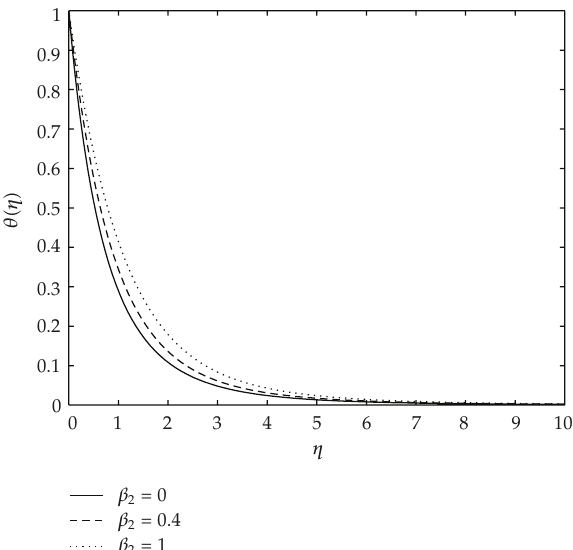
Figure 10: Temperature profiles for various values of β 2 with M (cid:5) 1, Pr (cid:5) 0 . 72, m (cid:5) 1, β 1 (cid:5) 0 . 1, and S (cid:5) 0 . 8 .